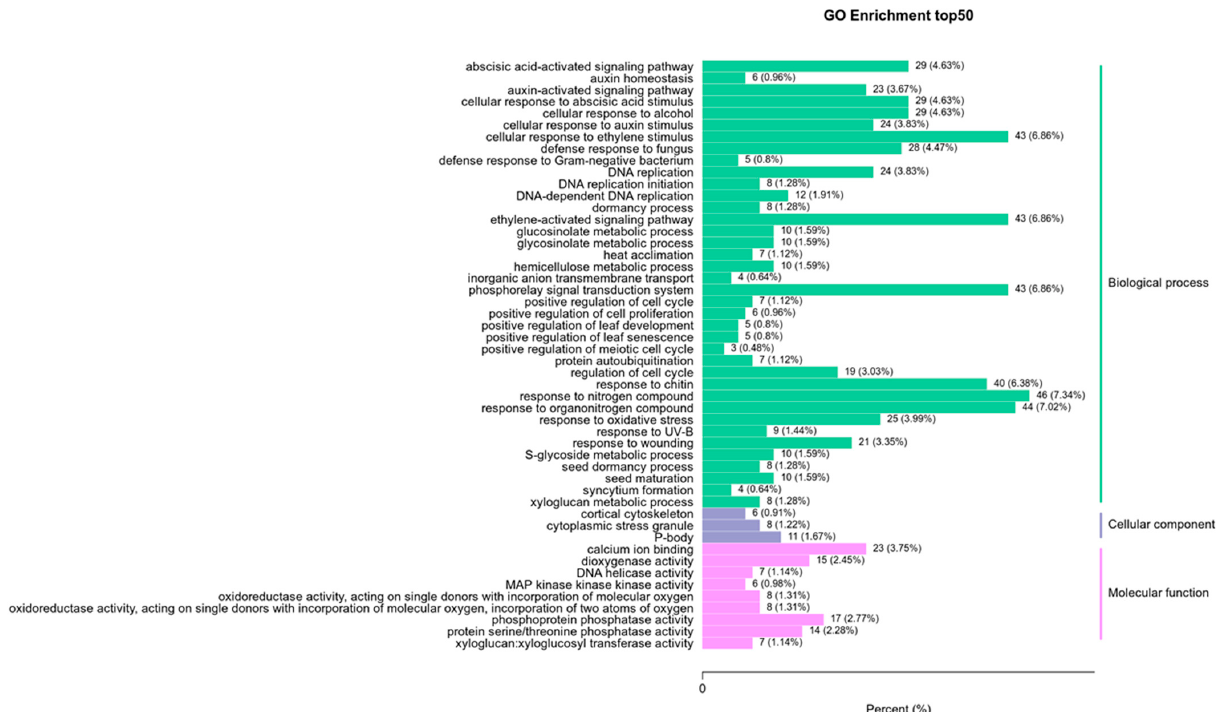
Figure 4. Differentially expressed genes (DEG) in kiwifruit ( Actinidia chinensis ) ‘Donghong’ in re- sponse to different treatments during fruit ripening stages. ( A ) The heatmap of DEGs from different treatments. ( B ) Venn enrichment analysis of DEGs.